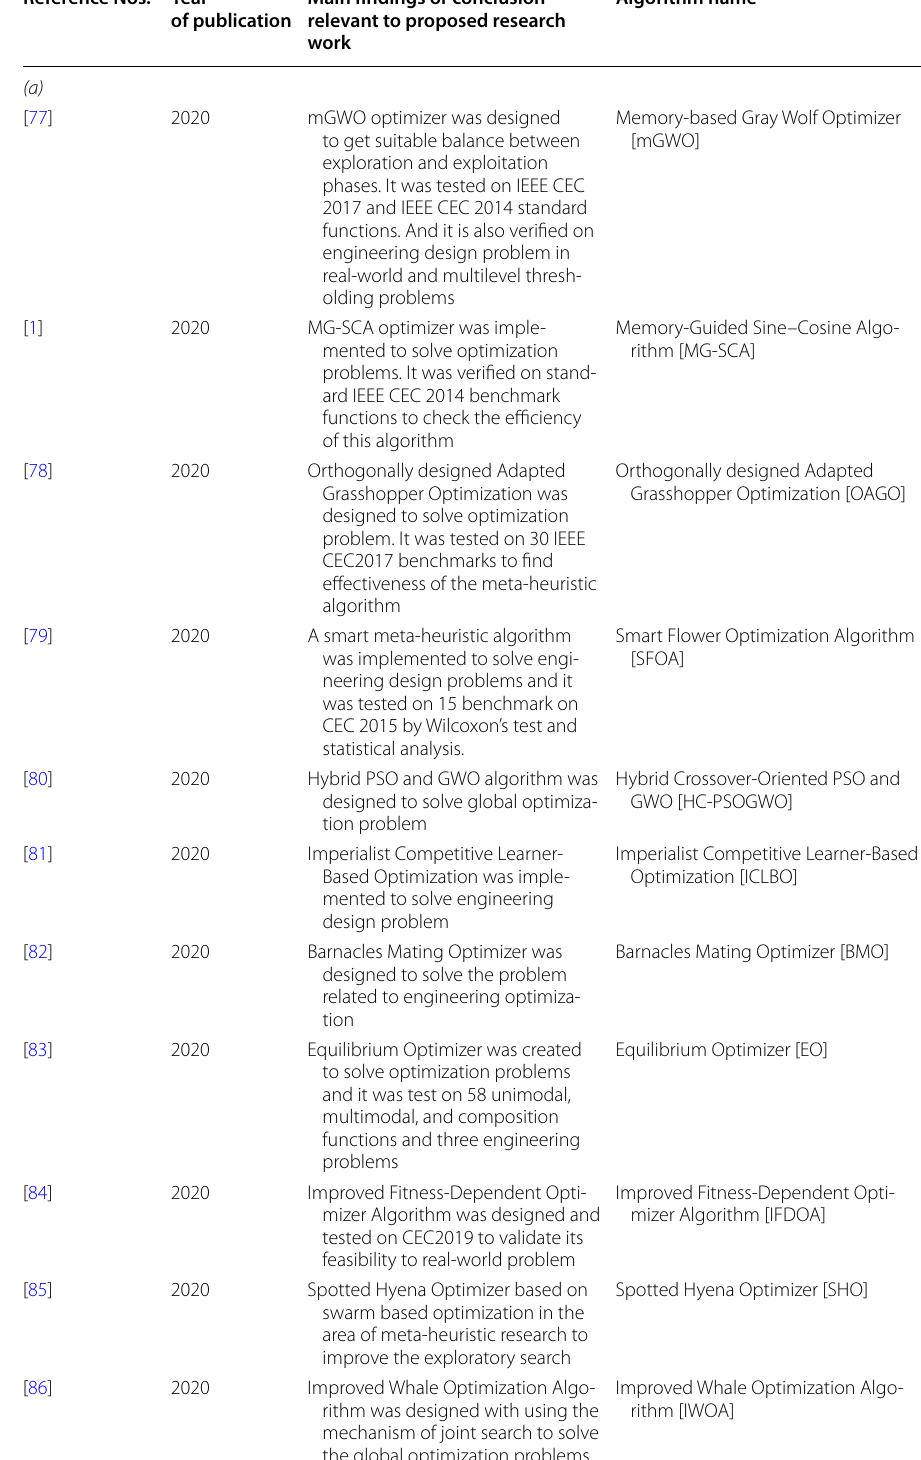
Table 1 (a) Assessment of several heuristics and meta-heuristics search optimization techniques. (b) Literature survey of unit commitment. (c) Literature survey of wind power uncertainty. (d) Literature survey of solar uncertainty Reference Nos. Year Main findings or conclusion of publication relevant to proposed